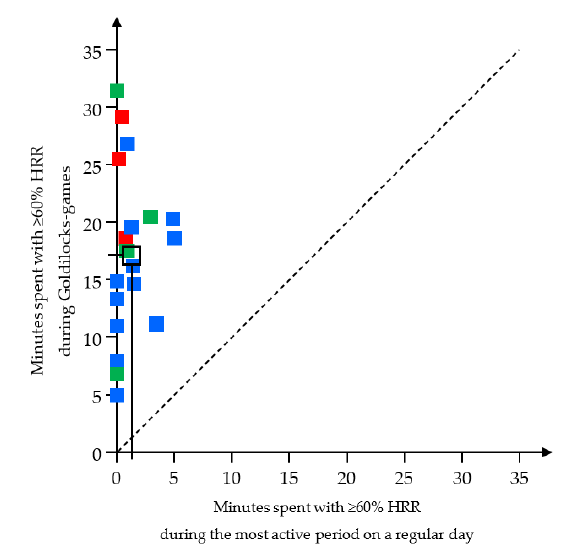
Figure 6. Minutes spent in HIPA (≥60% HRR) during the most active period in a regular workday (x-axis), and during Goldilocks-games (y-axis). Red, blue and green symbols show values for each individual childcare worker in the ‘below average’, ‘average’ and ‘above average’ fitness groups, respectively; the black square (with vertical and horizontal lines) marks the arithmetic mean of the entire group ( n = 19). The dashed line illustrates the line of identity. Abbreviations: HRR, heart rate